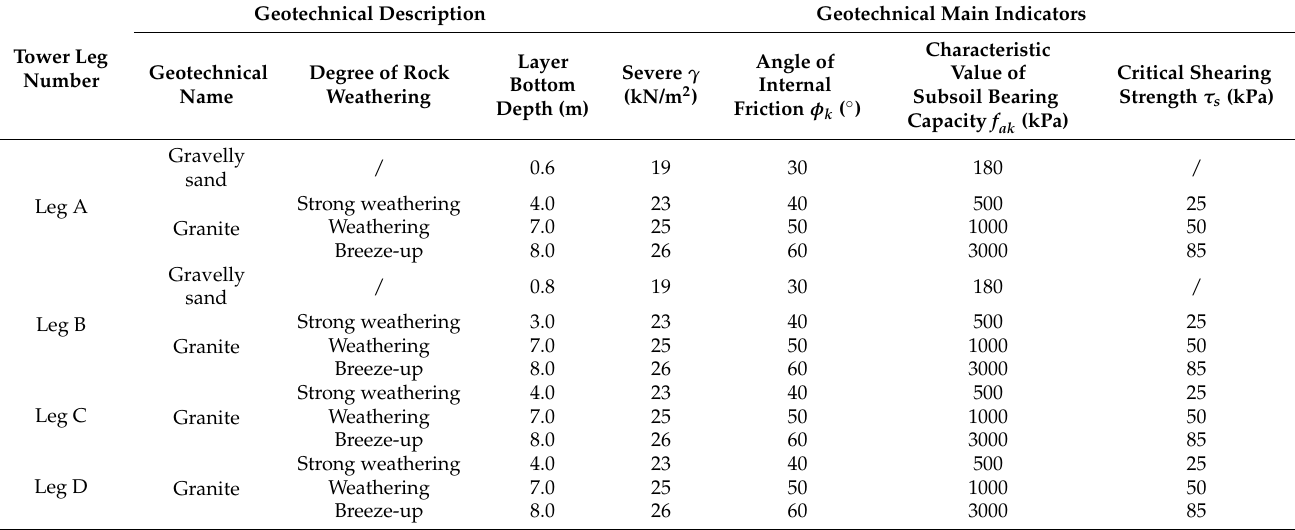
Table 2. Engineering geology